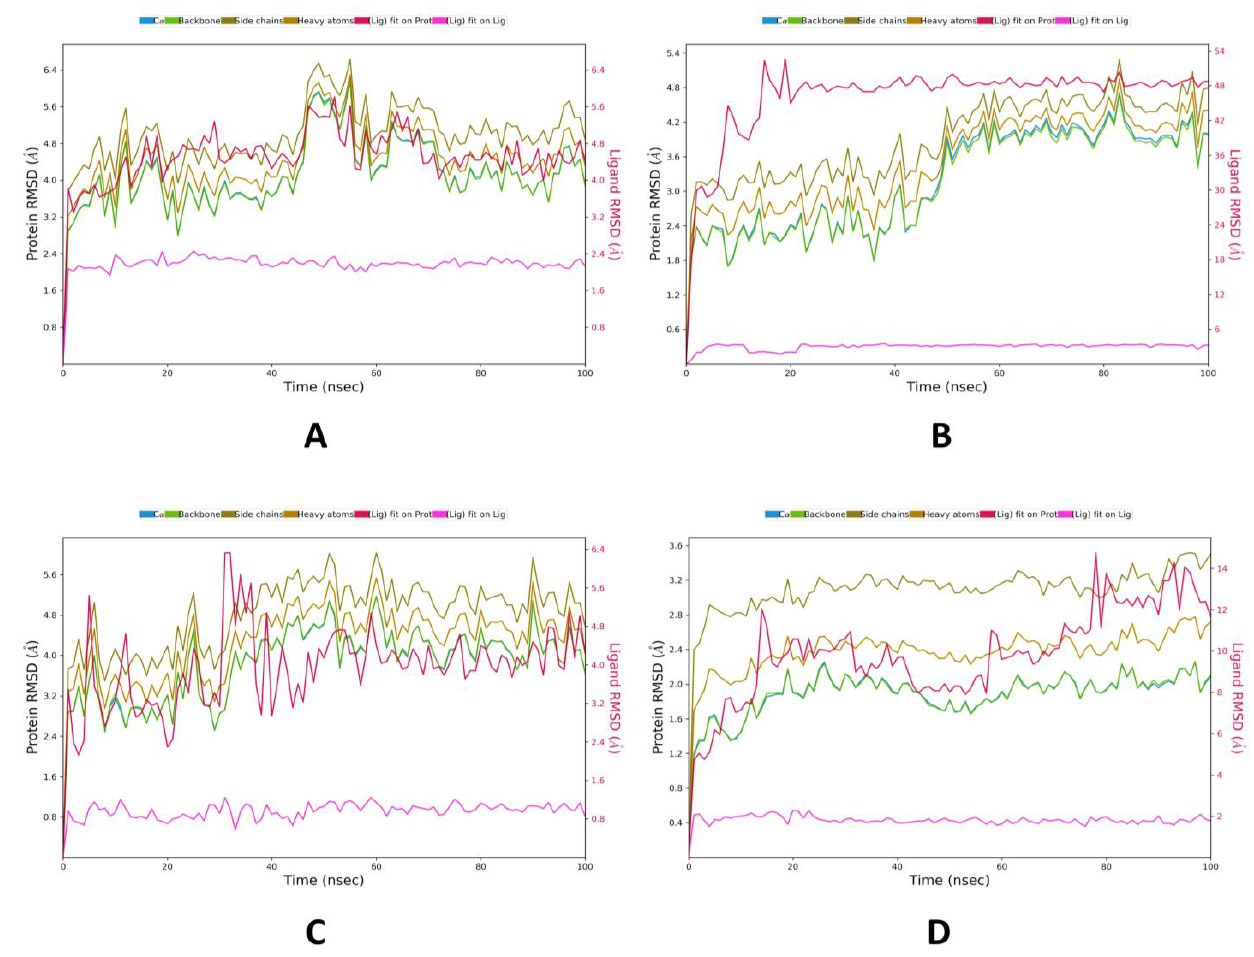
Figure 2. MD simulation protein–ligand interaction root-mean-square deviation (RMSD) profile of casuarinin with target proteins. ( A ) 4YAY, ( B ) 4DLI, ( C ) 1HW9, ( D ) 1B09. Color legends: Ca (blue color), side chains (green color), heavy atoms (yellow color), ligand with protein (dark pink color), ligand with ligand (pink color).